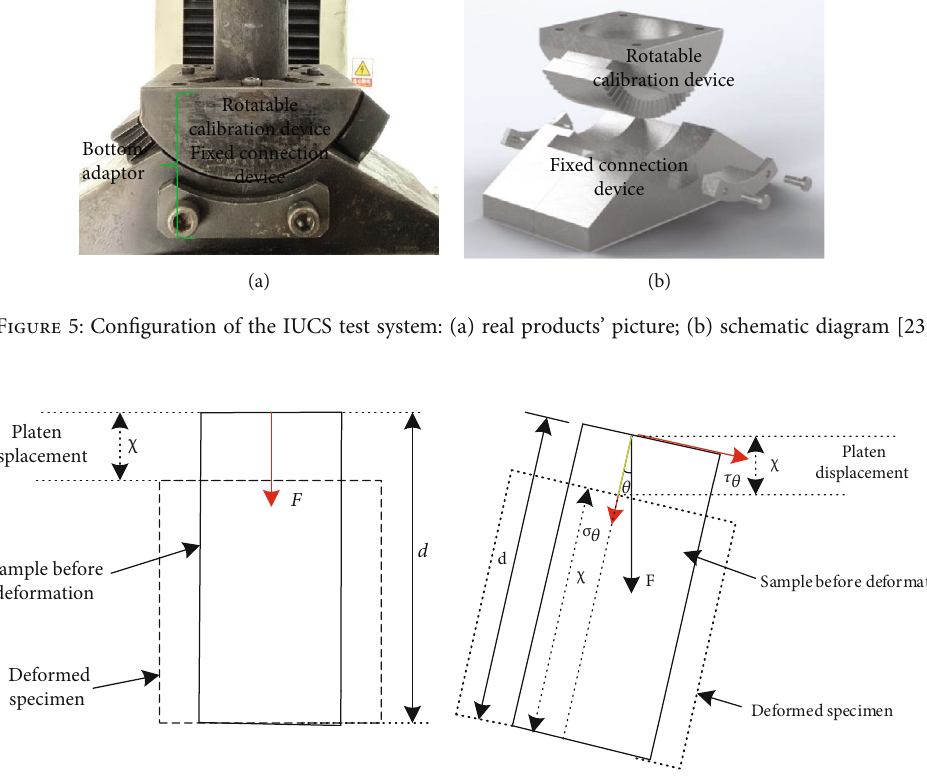
Figure 6: Stress and deformation state of the specimen before and after the test